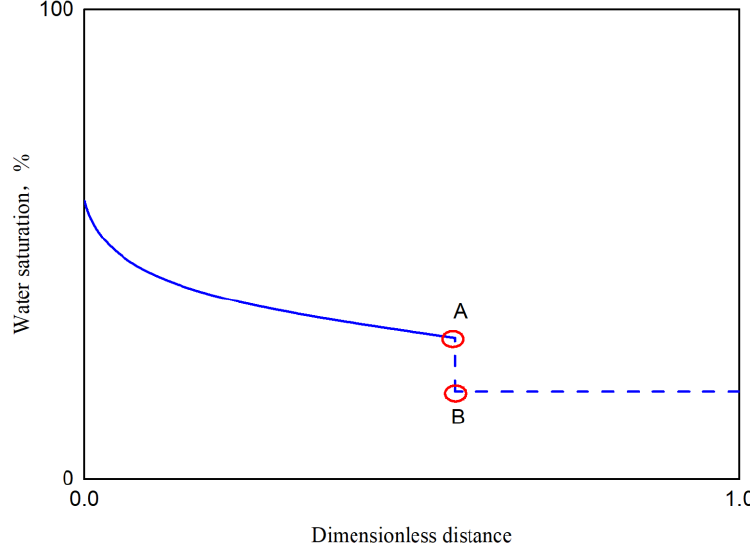
Figure 4. Schematic diagram of water saturation distribution along the flow. The accuracy of the model can be verified by comparing it with the water saturation along the flow obtained using the simulation